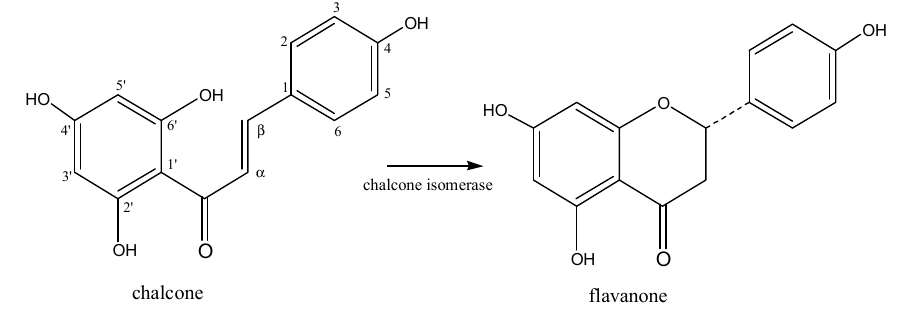
Figure 2. Chalcone isomerization to form a flavanone.